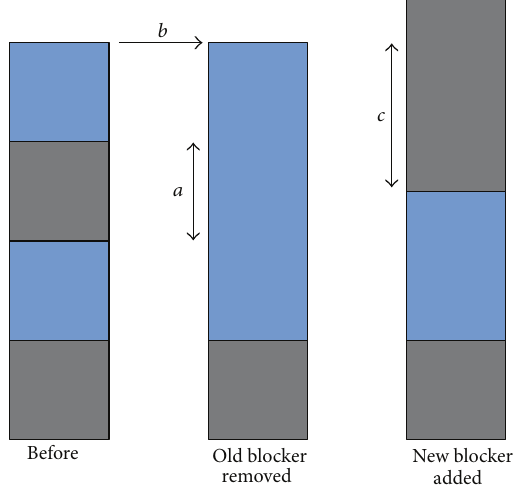
Figure 5: An example of the body update in a cell. During a time step, a submerged body rises above the surface. This is handled by first removing the old blocker. In this case, water needs to be added ( 𝑎 ) to keep the surface unchanged ( 𝑏 ). The new blocker is then added, removing any overlapping water ( 𝑐 ). In this case, the upper water column becomes